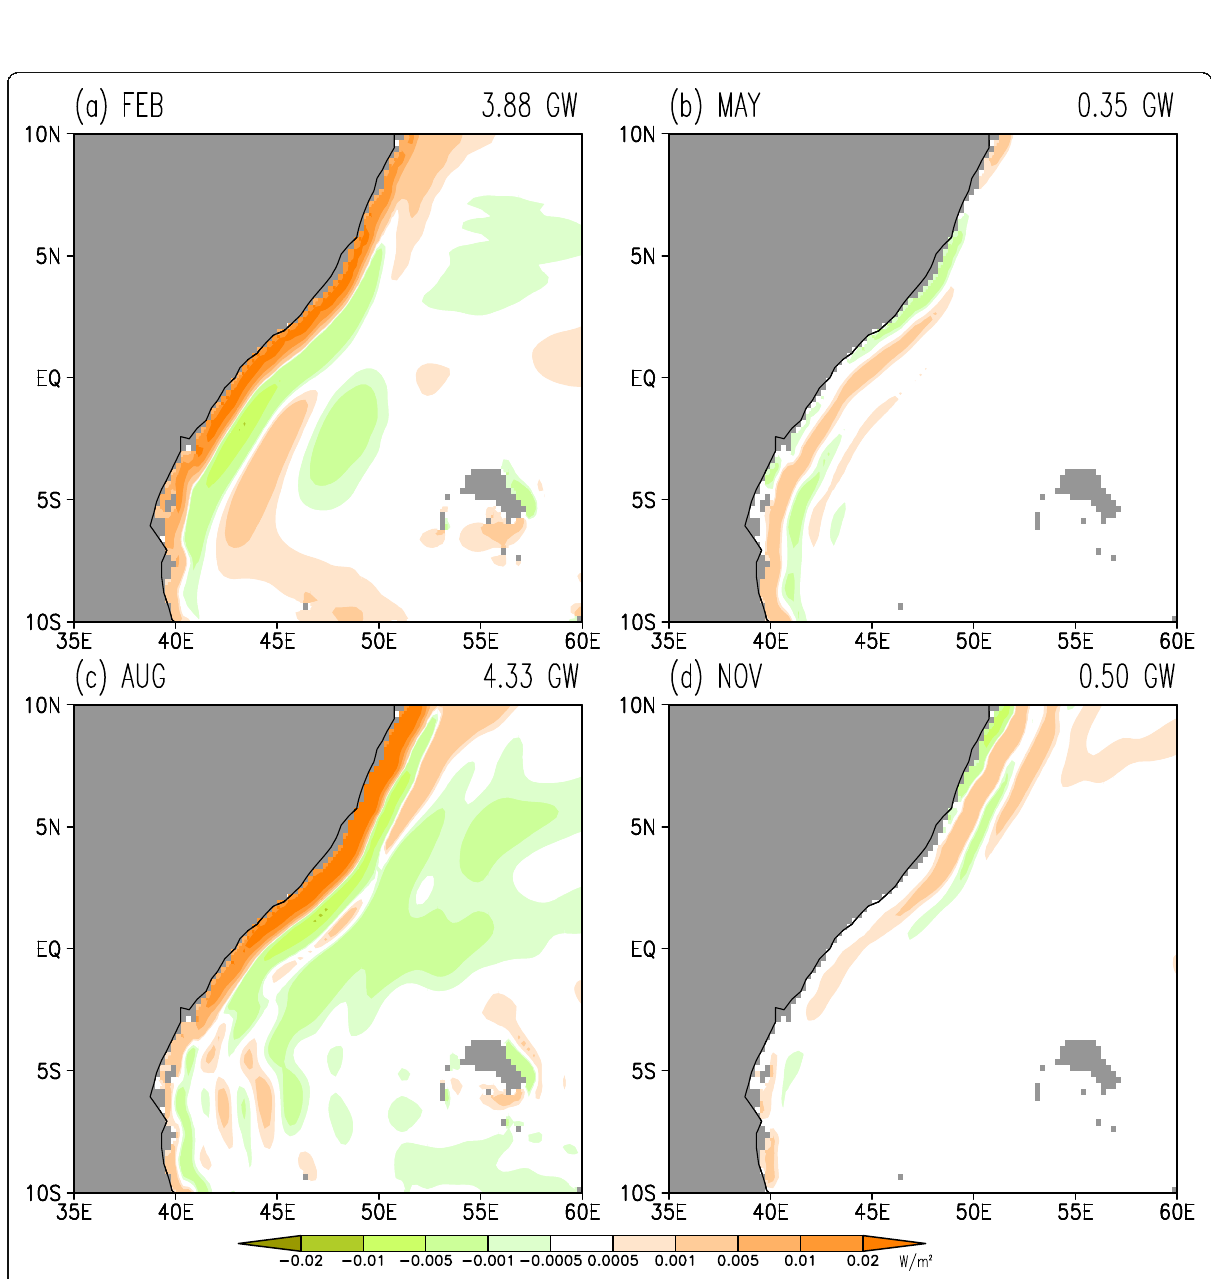
Fig. 7 Energy input rate by wind forcing ( W/m 2 ) near the African coast from “ Year 20 ” of our climatological model experiments associated with the sum of 6 baroclinic modes: a mid-February, b mid-May, c mid-August, and d mid-November. Spatially integrated values (35 – 60° E, 10° S – 10° N) of the wind input rate are shown in the title (10 9 W =